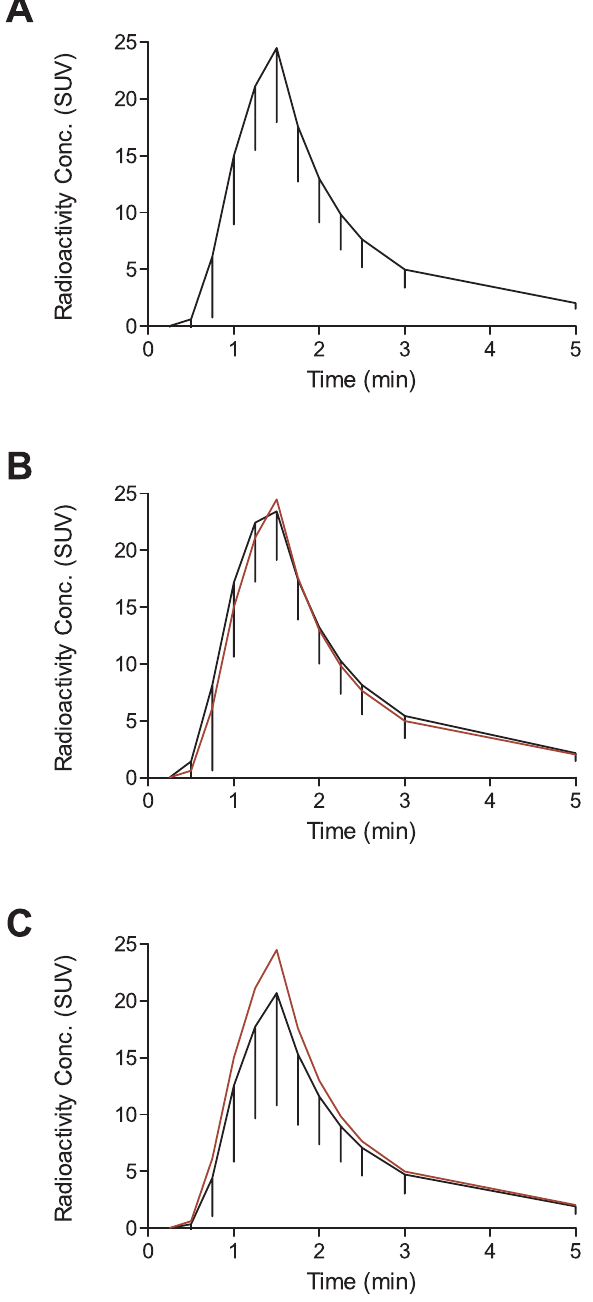
Figure 1. Comparison between the PBIF from healthy volun- teers and the average curves in alcoholic subjects and cannabis smokers. Average PBIF, expressed in SUV, from healthy subjects (A). Error bars show standard deviations for each time point. Only the first 5 minutes are shown. After 5 minutes, all curves are virtually identical. In panel B, the black curve, with SD, represents the average input function from alcoholic subjects and the superposed red curve is the PBIF from healthy subjects. The two average population curves are very similar in shape and magnitude. However, when compared to the average curve from cannabis smokers (in black, panel C), it can be clearly seen that PBIF (in red) overestimates the peak. This will translate into a selective underestimation of Logan- V T in the cannabis population.